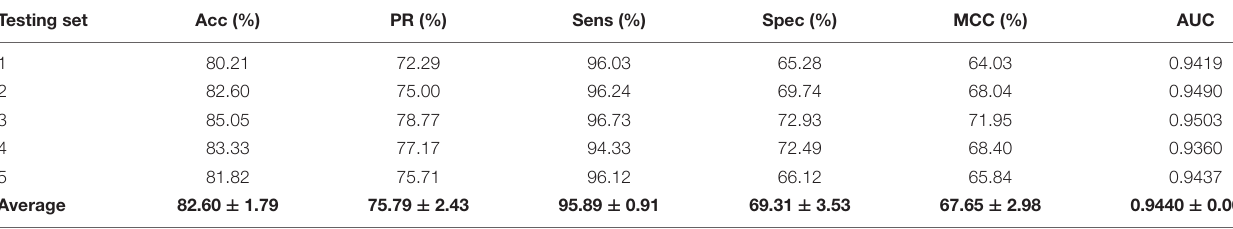
TABLE 3 | Five-fold CV results performed on the Oryza sativa dataset by the proposed model. Testing